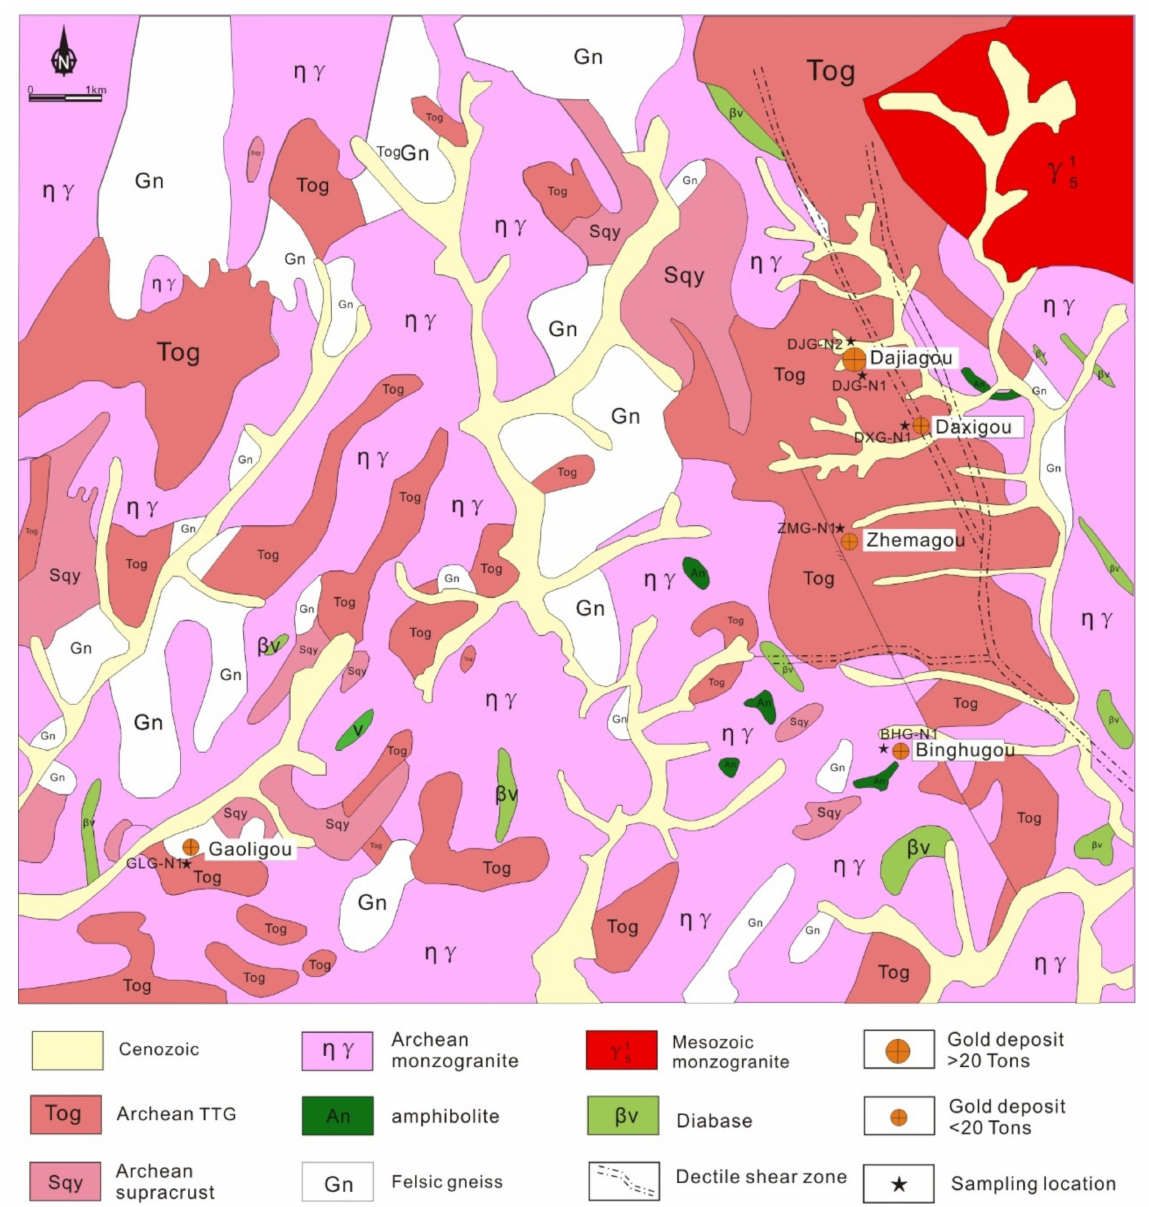
Figure 2. Simplified geological map of the Liuhe gold orefield, NE